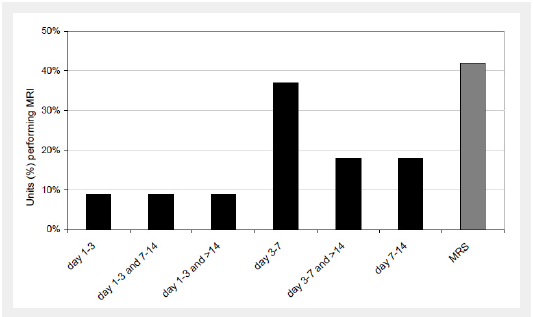
Figure 1 Timing of MRI in the units (n = 10) that routinely perform MRI in all infants with perinatal encephalopathy. MRS: Magnetic Resonance